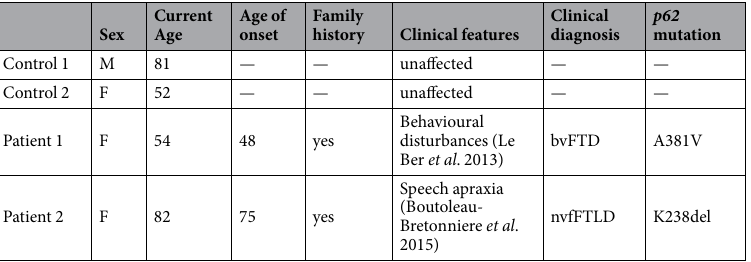
Table 1. Donors’ information. M: male; F: female; nfvFTLD: non-fluent variant of FTLD; bvFTD: behavioural variant of